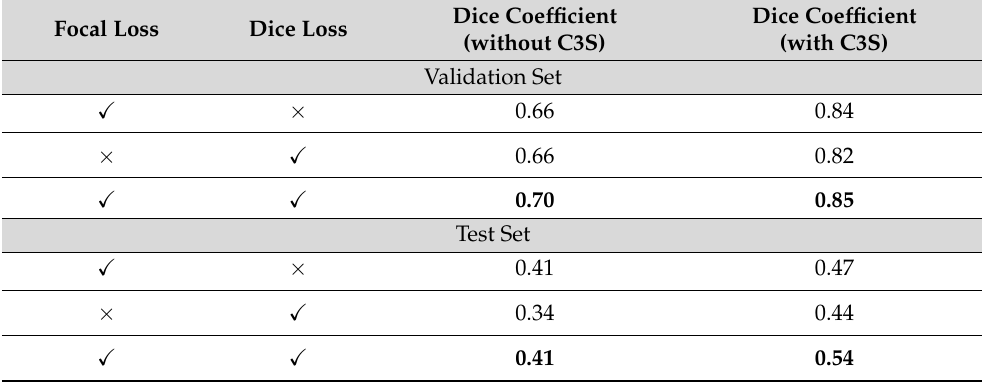
Table 3. Ablation experiments on the segmentation